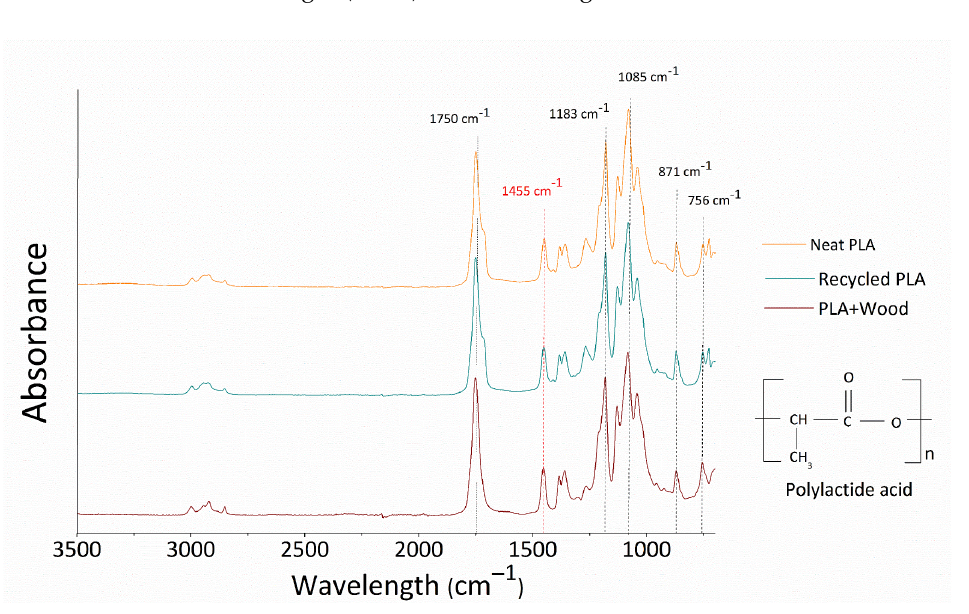
Figure 2. ATR spectra of investigated filaments.